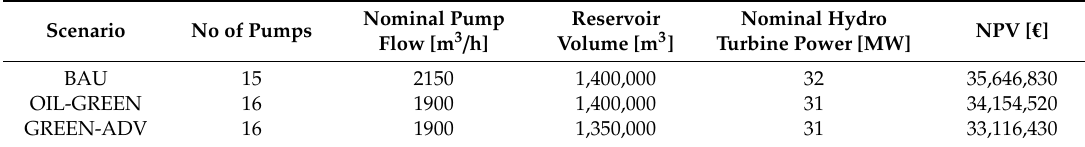
Table 4. The dimensions of the optimal PSP for each scenario.